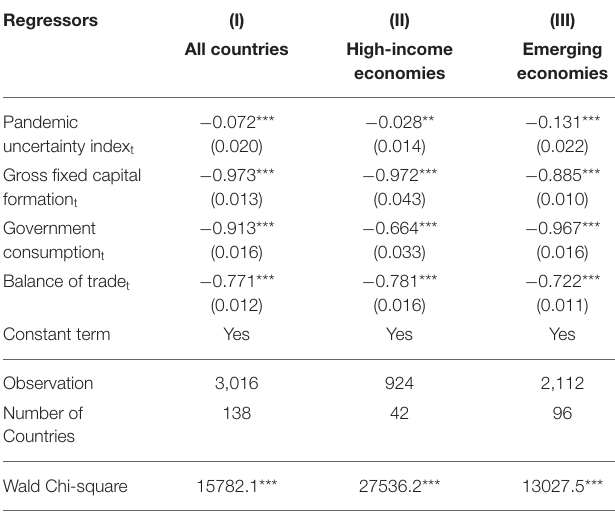
TABLE 4 | FGLS Estimations: pandemics and household consumption